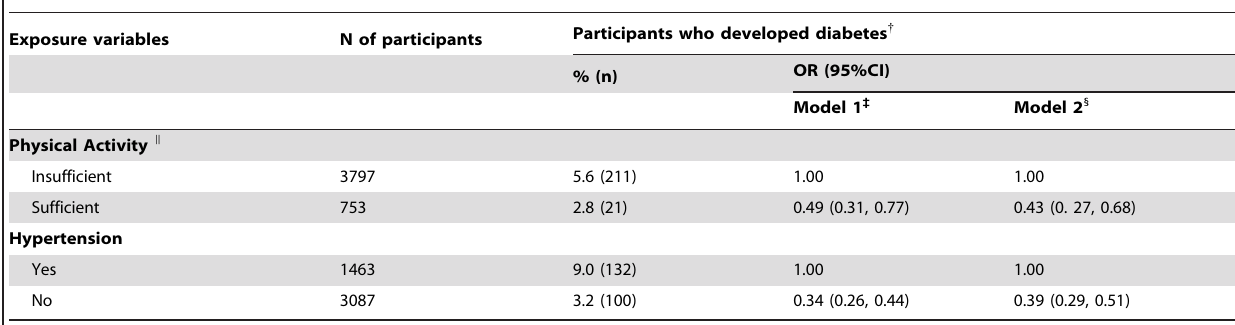
Table 2. The separate association of physical activity and hypertension with subsequent diabetes at three-year follow-up among overall sample population in urban areas of Nanjing,